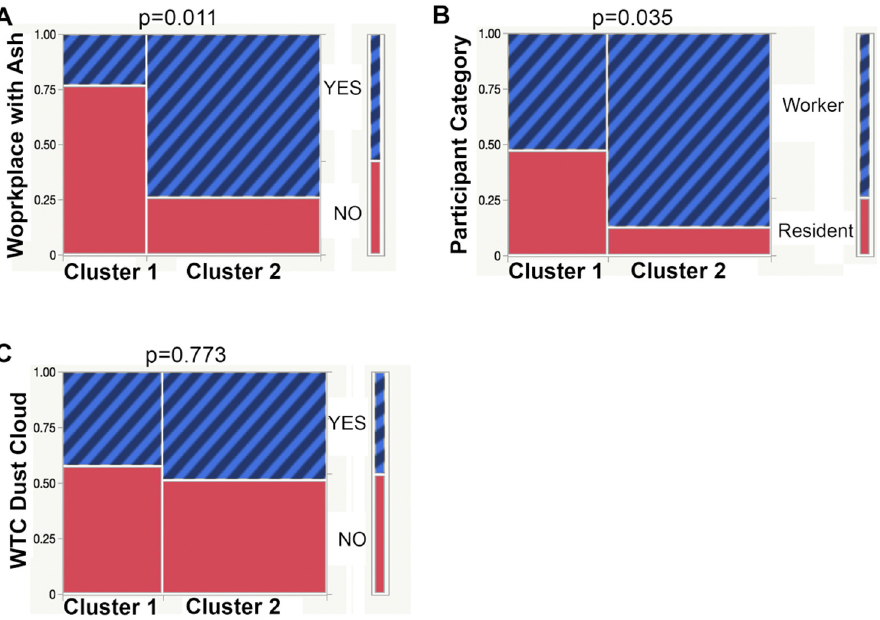
Figure 3 . Mosaic plots show the comparison of WTC survivor clusters (cluster 1, cluster 2) for the WTC exposure categorical variables, ( A ) Workplace with ash (no/yes), ( B ) Participant category (resident/worker), ( C ) WTC dust cloud at 9/11 (no/yes). Cluster 1: n = 13 – 19, cluster 2: n = 27 – 31 were compared by logistic regression adjusting for age, BMI, gender, and race/ethnicity. p values are indicated on top of each plot.